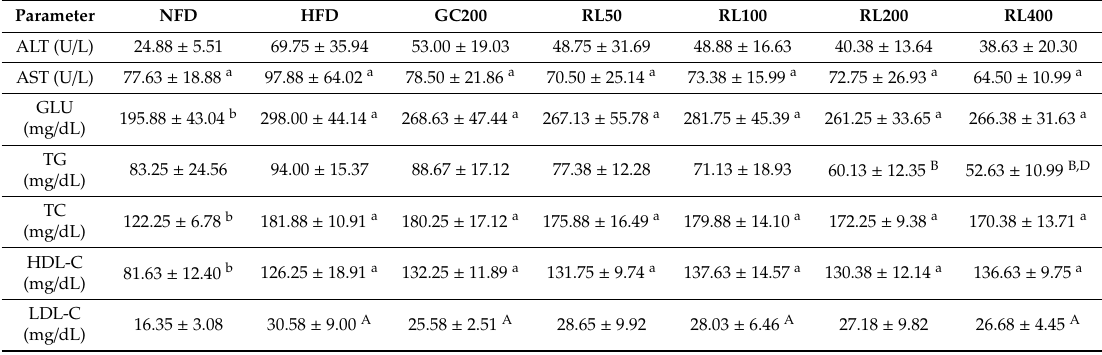
Table 4. E ff ects of RL at various concentrations on serum lipid biomarkers in high-fat diet-induced obese C57BL / 6J mice.